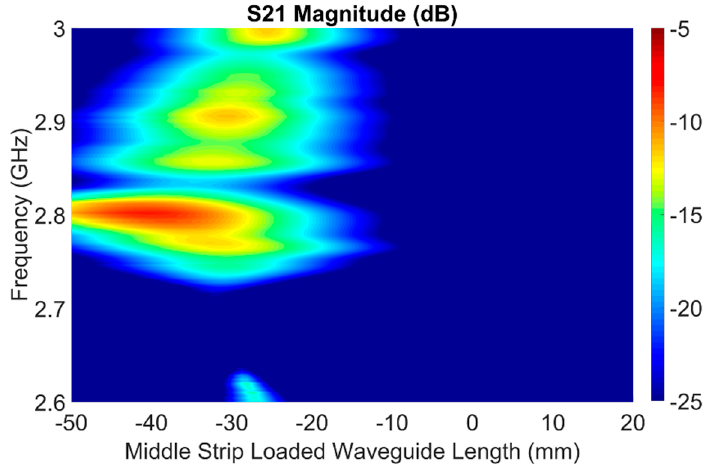
Figure 10. Transmission ( S 21 ) magnitude versus frequency and length of the middle strip loaded waveguide ( l Strip2 ). Peak transmission occurs at 2.8 GHz when the length of the middle strip loaded waveguide ( l Strip2 ) is − 40.8 mm. (In color.).